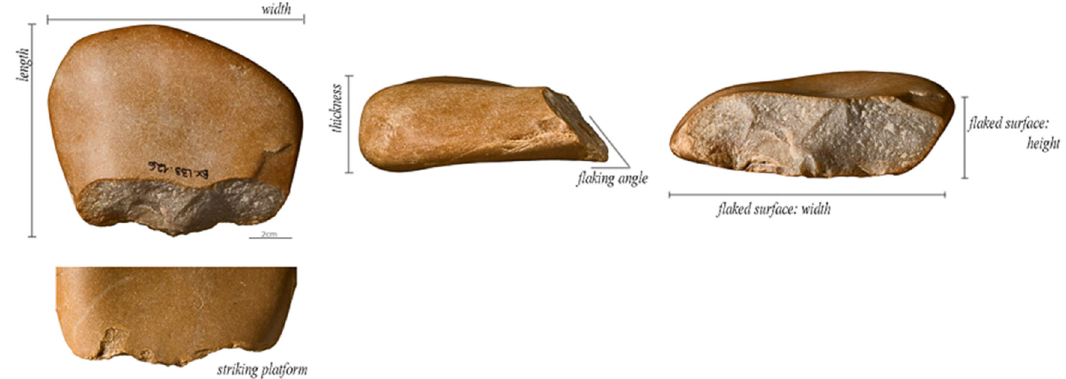
Figure 11: Barca do Xerez de Baixo: cobble thickness guided the production of fl akes at the site. Photo, J. P.